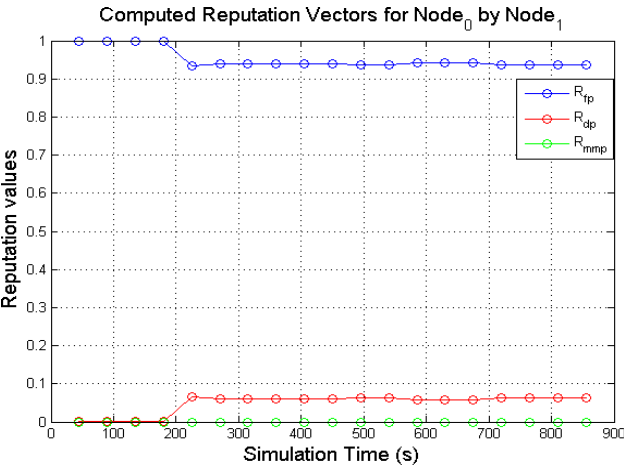
Figure 5. Reputation values for a good node ( N 0 ) calculated by another good ( N 1 ).